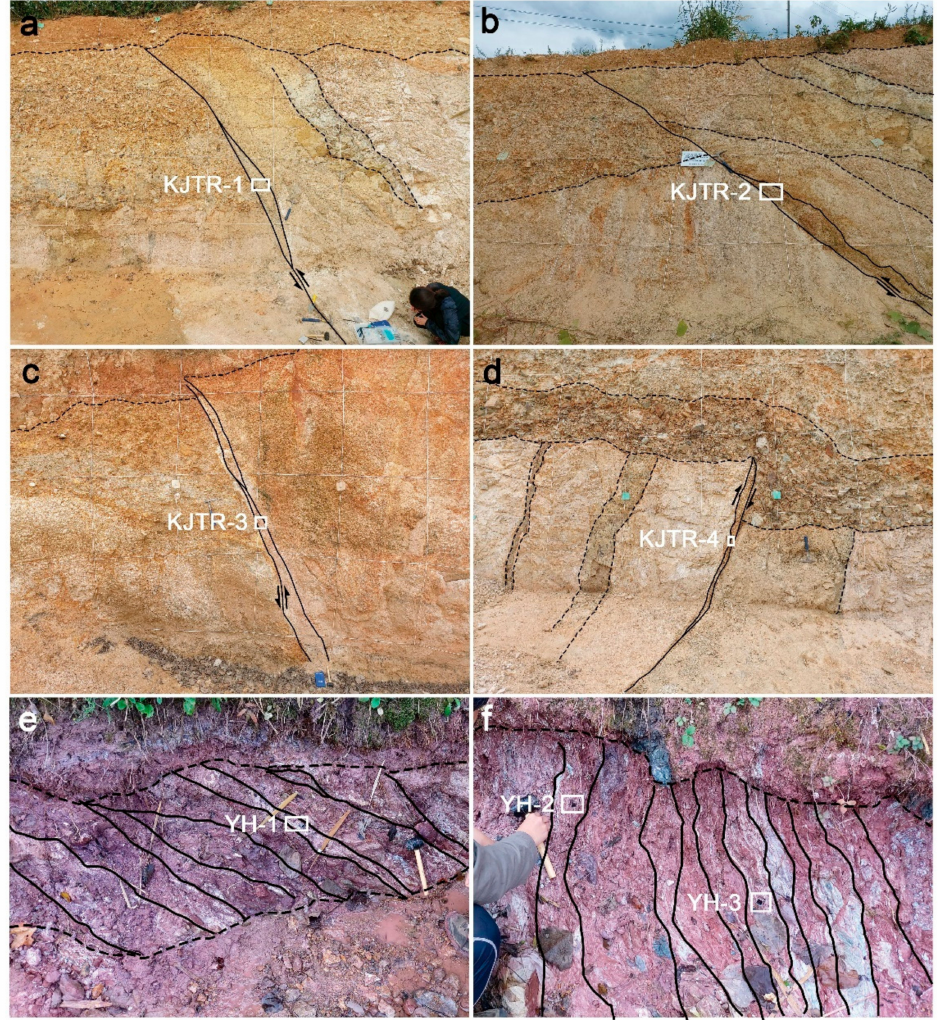
Figure 2. Photos of outcrops from which samples were taken. ( a – d ) Four samples (Ulsan fault site (KJTR)-1, -2, -3, -4) were collected from the trench outcrops shown at the KJTR site. The fault plane is represented by solid lines and the foliation observed in the surrounding rock and distinct layer boundaries observable in the field are represented by dotted lines; ( e , f ) Two samples (Yangsan fault site (YH)-1 and -2) were obtained from the fault zone at the YH site. Fault traces are shown as solid lines, and the bedrock-soil interface as dashed